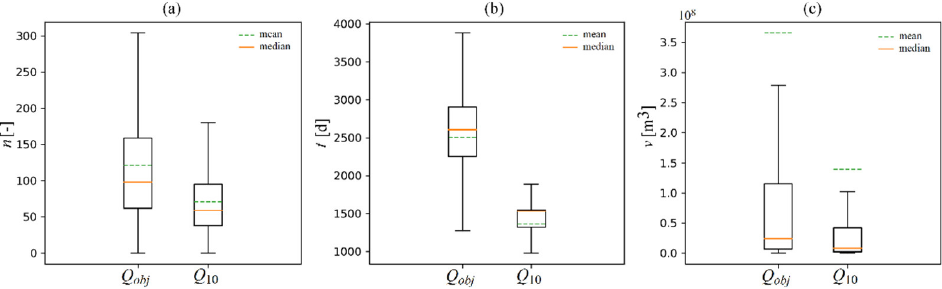
Figure 8. Box and whisker plots of the number of low flow events. ( a ): Total duration of low flows and ( b ) total volume of low flows ( c ) over the study period; graphs do not include outliers. The duration of the low flows varied slightly more than the number of events. In